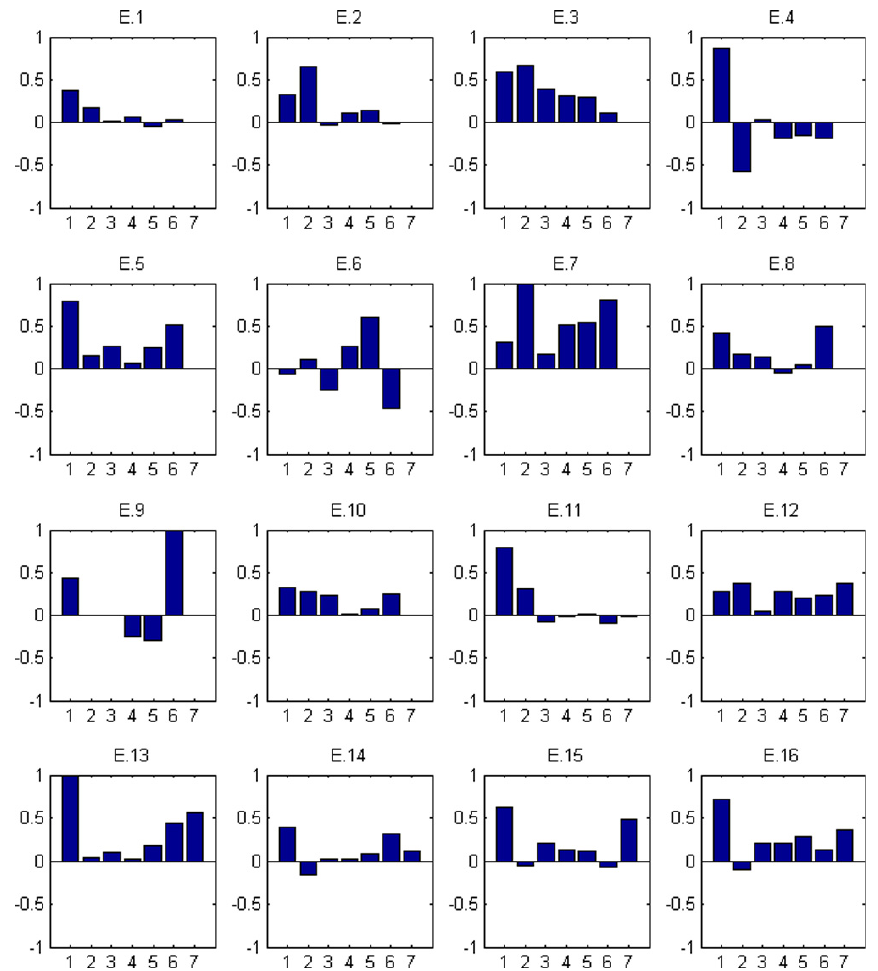
Fig. 5. Relative difference of total rainfall for each event computed between radar rainfall data and corresponding rain gauges 1 to 7 (1-Anduze, 2-Barre, 3-Mialet, 4-Roman, 5-Saumane, 6-Soudorgues and